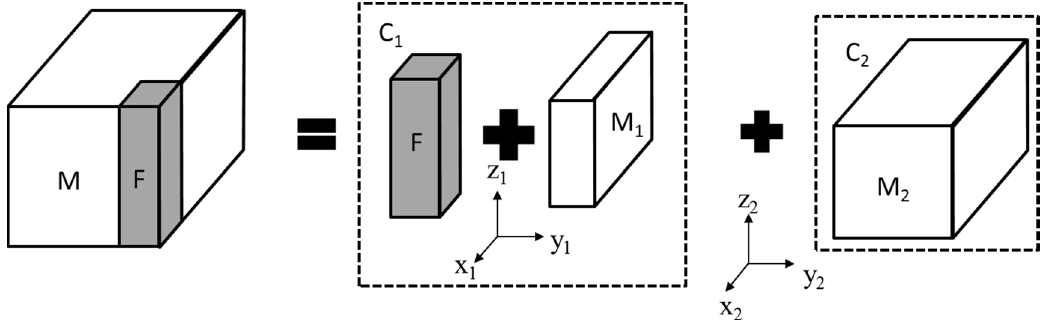
Figure 1. Schematic of a unit cell used in the KCL model.